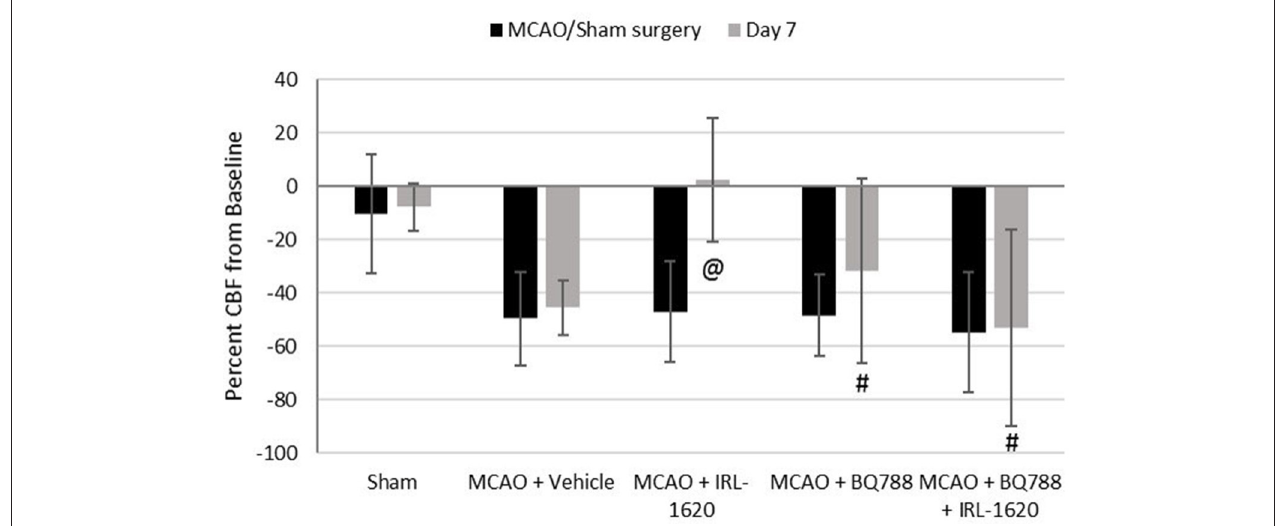
FIGURE 1 | Percent change in cerebral blood flow (CBF). Treatment with IRL-1620 lessens the reduction in CBF after middle cerebral artery occlusion (MCAO). This effect was blocked by treatment with ETB antagonist BQ788. Groups I-III: n = 6, Group IV: n = 5, Group V: n = 4. Values are presented as mean ± SD. P < 0.05: @, compared to vehicle group; #, compared to IRL-1620 group.